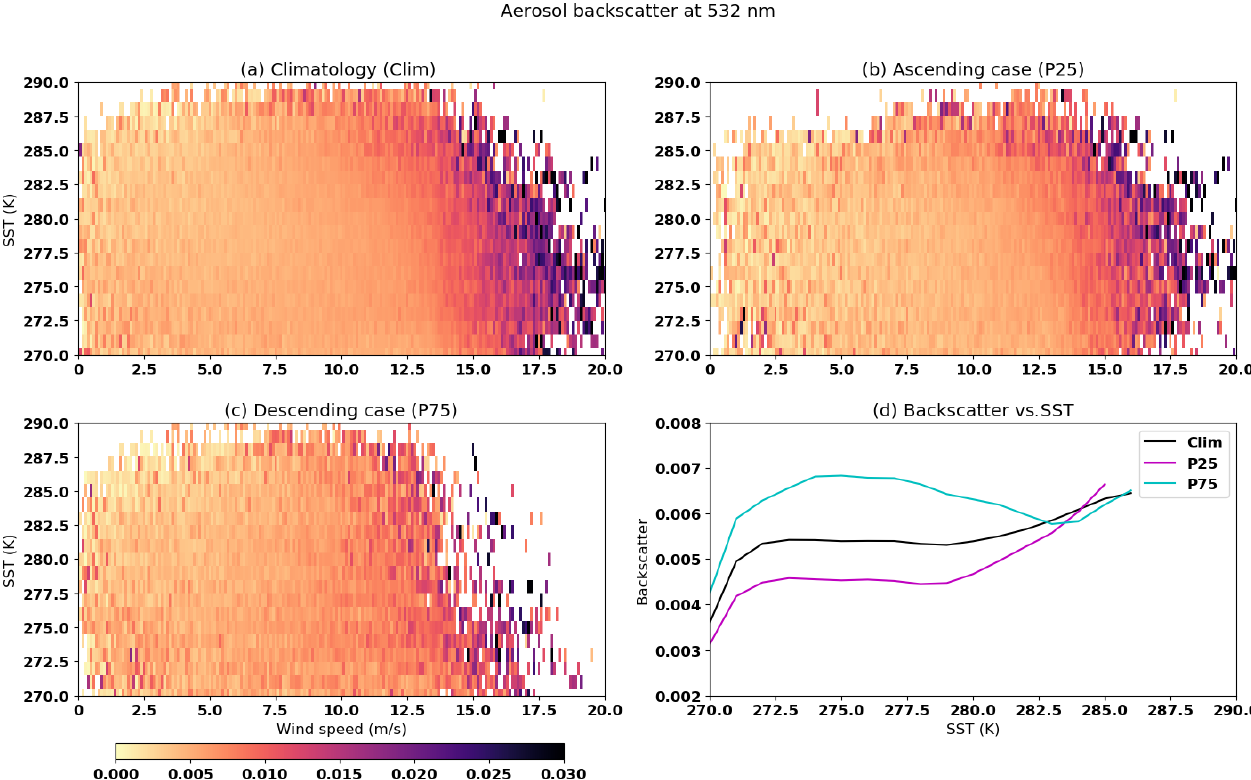
Figure 4. Total backscatter coefficient at 532nm (km − 1 sr − 1 ) as a function of surface wind speed and temperature. (a) Climatological conditions, all aerosol profiles included; (b) ascending case, only when 700hPa geopotential height is less than 25th percentile (P25); (c) descending case, only when 700hPa geopotential height is greater than the 75th percentile (P75); and (d) expressed only as a function of temperature (averaged over all wind